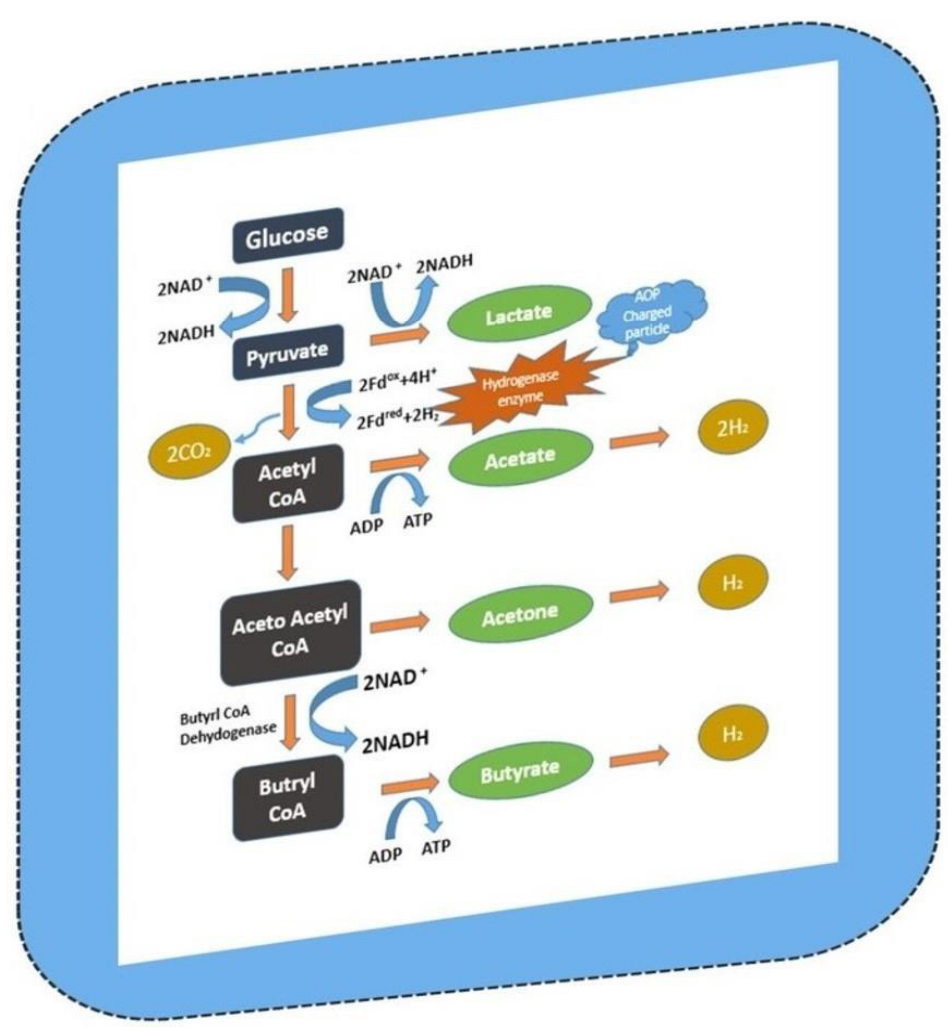
Figure 1. Biohydrogen production pathway in Dark Fermentation process.